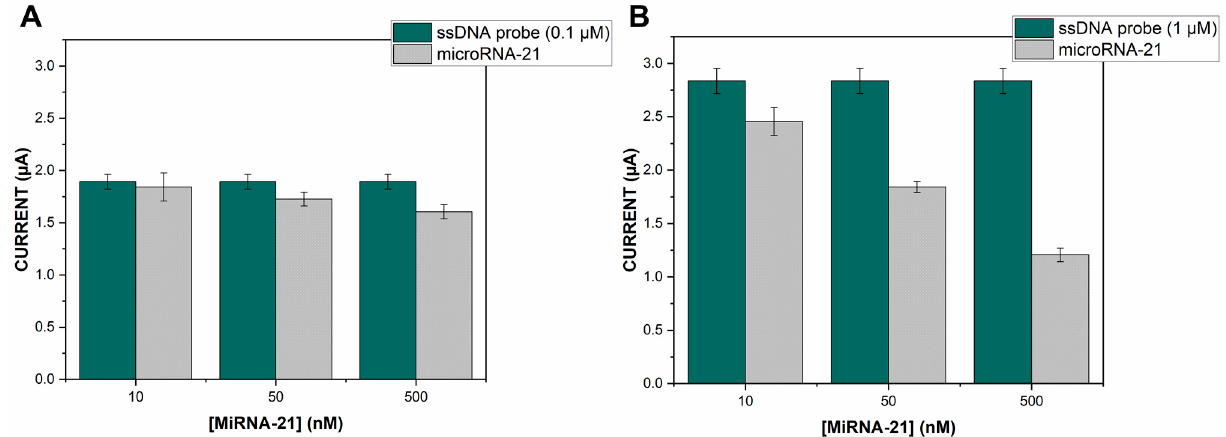
Figure 7. Differential pulse voltammetry reduction current of MB on BSA/ssDNA/CysAm/AuNPs/CB/PGE after the immobilization of 0.1 µM ( A ) (RSD% = 7.20%, 3.76%, 4.25%) and 1 µM ( B ) (RSD% = (5.28%, 2.75%, 5.24%) of ssDNA capture probe and the incubation with 10, 50, and 500 nM of microRNA-21 target concentration. Incubation in 20 µM MB at Tris-HCl buffer (20 mM, pH 7.00) including 20 mM NaCl for 5 min and washing with the same buffer including 20 mM NaCl (n = 3).